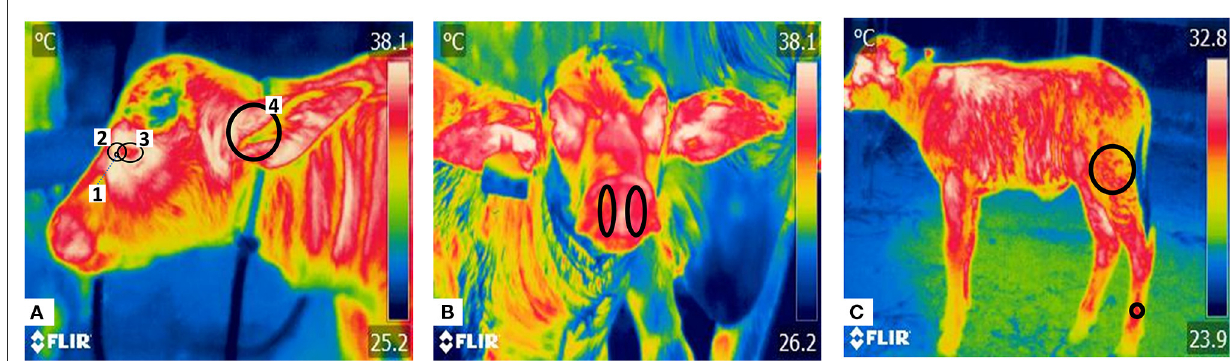
FIGURE1 Thermal windows in newborn water buffaloes. Thermal windows captured in three radiometric images (lateral facial, frontal facial, and latero-lateral). (A) The lateral facial view shows four thermal windows: (1) the lacrimal gland, delimited by a circle in the medial quadrant of the ocular orbit; (2) the lacrimal caruncle, delimited by a circle around the lacrimal gland, from the medial region of the eye toward the rostral area of the palpebral commissure; (3) the periocular region, outlining the upper and lower eyelids in an ellipse; and (4) the auditory canal, marked with a circle covering the entire acoustic meatus. (B) Frontal facial region with delimitation of the nostrils. The temperature irradiated from this area was registered by drawing an ellipse based on each nostril’s upper and lower end. (C) Latero-lateral region, where two thermal windows can be observed. The pelvic limb is delimited by two circles: one placed at the insertion of the M. biceps femoris and the second at the distal end, 10cm above the hooves, located in the superficial digital flexor muscle . The average values of these measures were obtained.